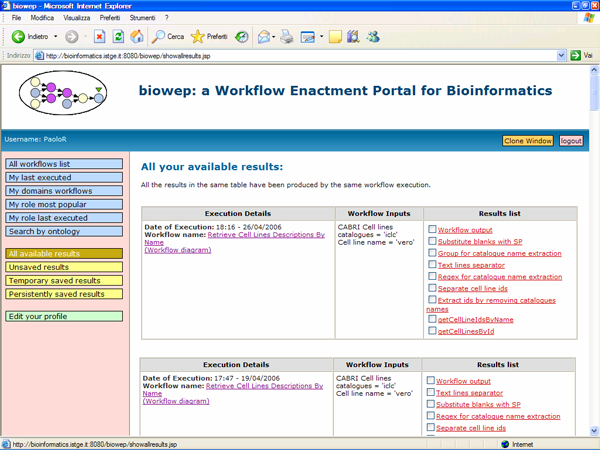
List of results of previous executions. In this figure, the web page listing all results is shown. For each execution, input values are reported. Results of all elaboration steps are listed and can be seen (by using a java library that must be downloaded and installed locally). A link to the diagram of the workflow is also available.